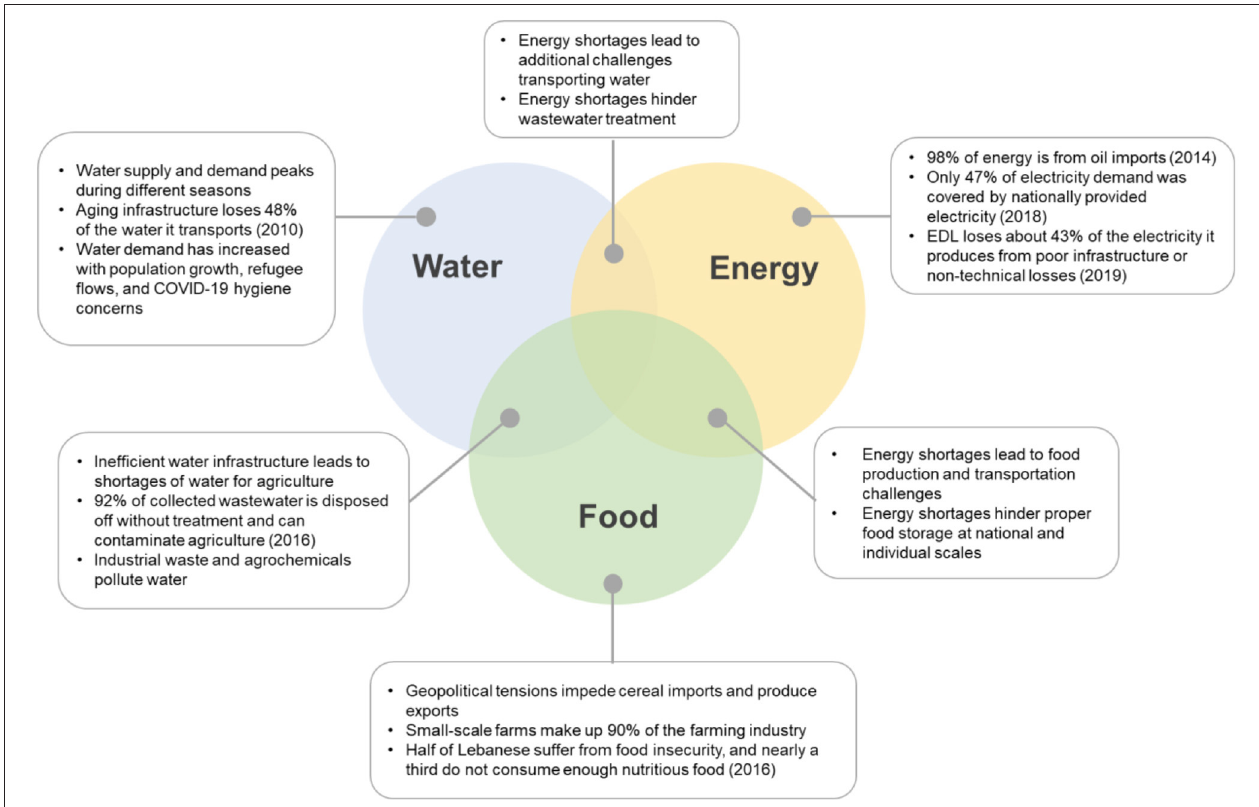
FIGURE 3 | Summary of the key challenges within and across the interconnected resource systems (El-Fadel et al., 2000; Bassil, 2010; OECD IEA, 2014; UNDP, 2014; ESCWA, 2016; Karnib, 2016; Soyres and Nakhle, 2019; MOA, 2020; Moore and Collins,